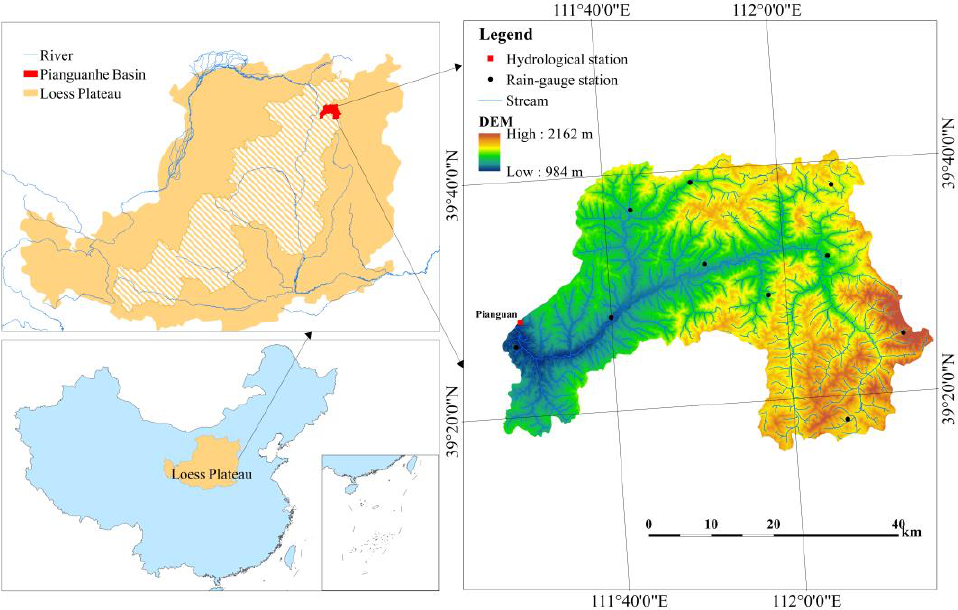
Figure 1. Location of the study area.